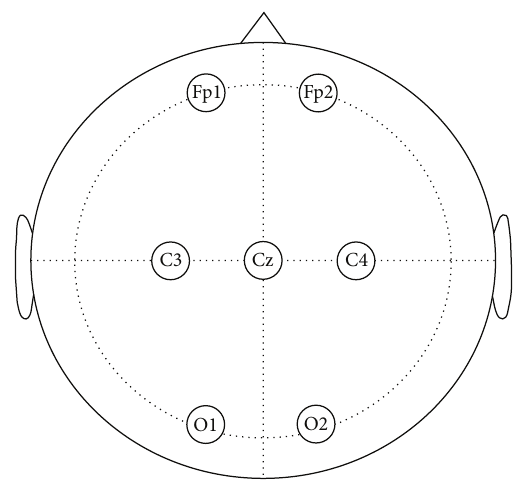
Figure 2: Placement of the EEG electrodes on the scalp according to the recording 10–20